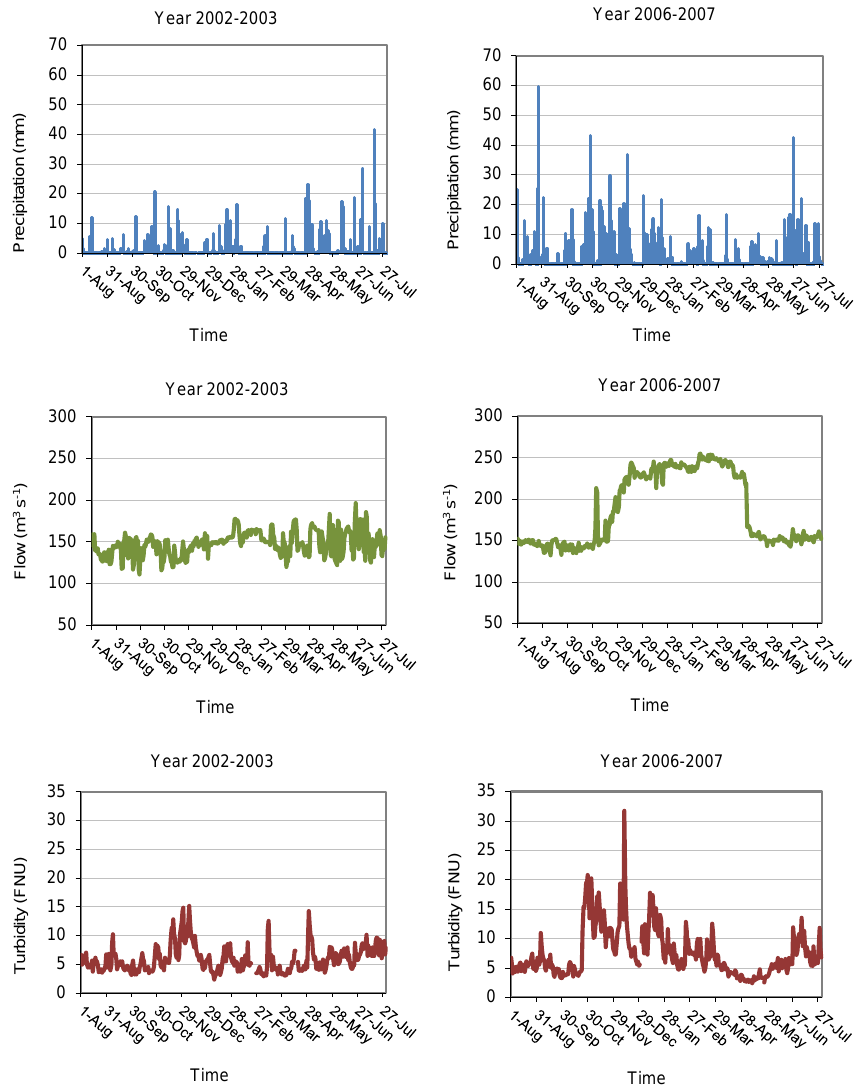
Fig. 3. A time series of precipitation, flow and turbidity in the southern branch of river G¨ota ¨Alv for the hydrologic years of 2002/2003 and